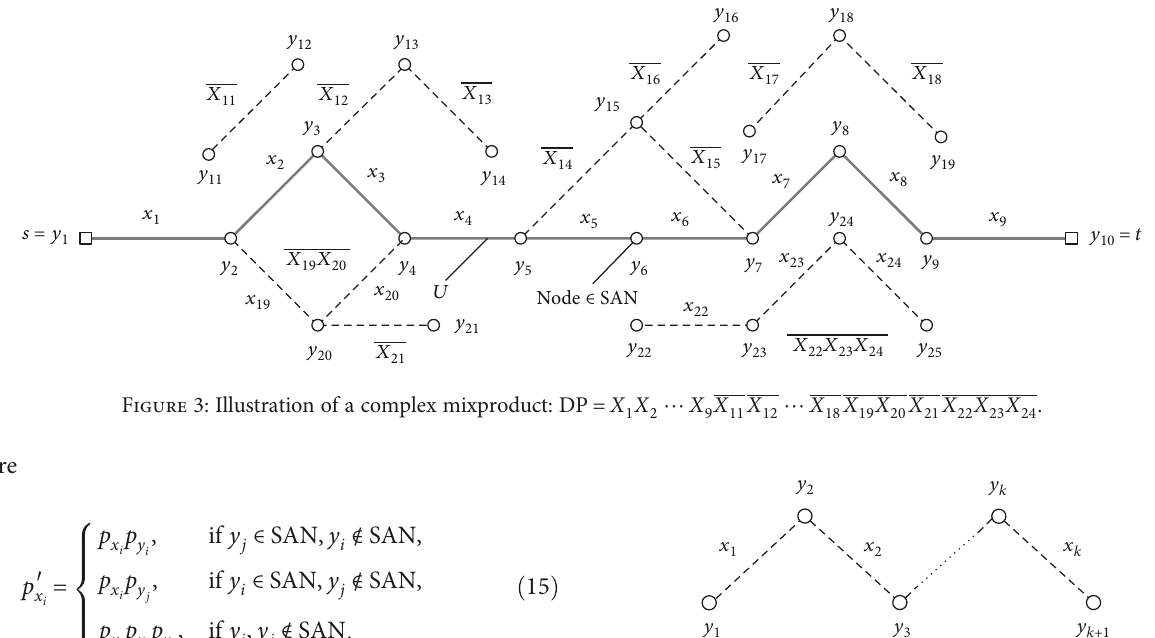
Figure 4: Illustration of a MVI term: X